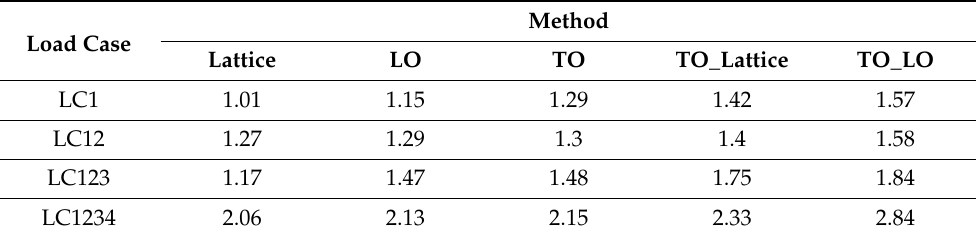
Figure 8. The design solutions in the five different methods for a 50% weight reduction in all LCs: ( a ) Lattice, ( b ) LO, ( c ) TO, ( d ) TO_Lattice, and ( e ) TO_LO. Table 3. The FOS results of the validation studies of macroscale and mesoscale TO.